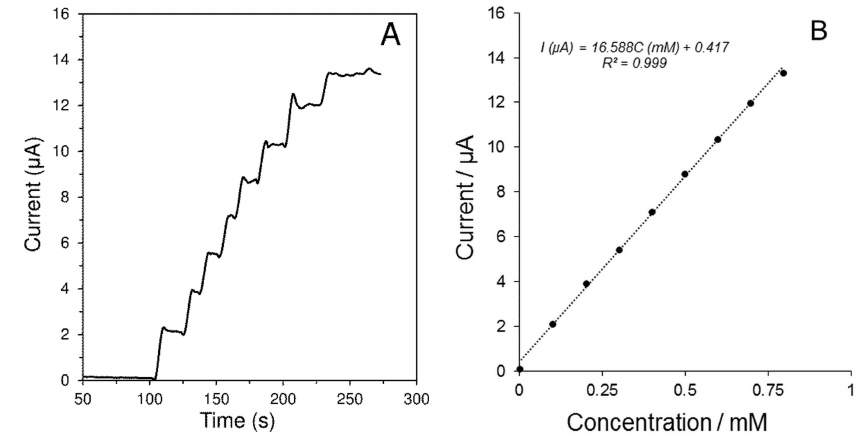
Figure 2. Amperometricrecords( A )andappropriatecalibrationcurve( B ),obtainedatGCE / MWCNTs-RuO 2 / Nafion ® to additions of 10 µ L H 2 O 2 (0.1 M). The measurements were performed in 0.1 M PB of pH 7.0 at potential + 0.4 V and speed of stirring 400